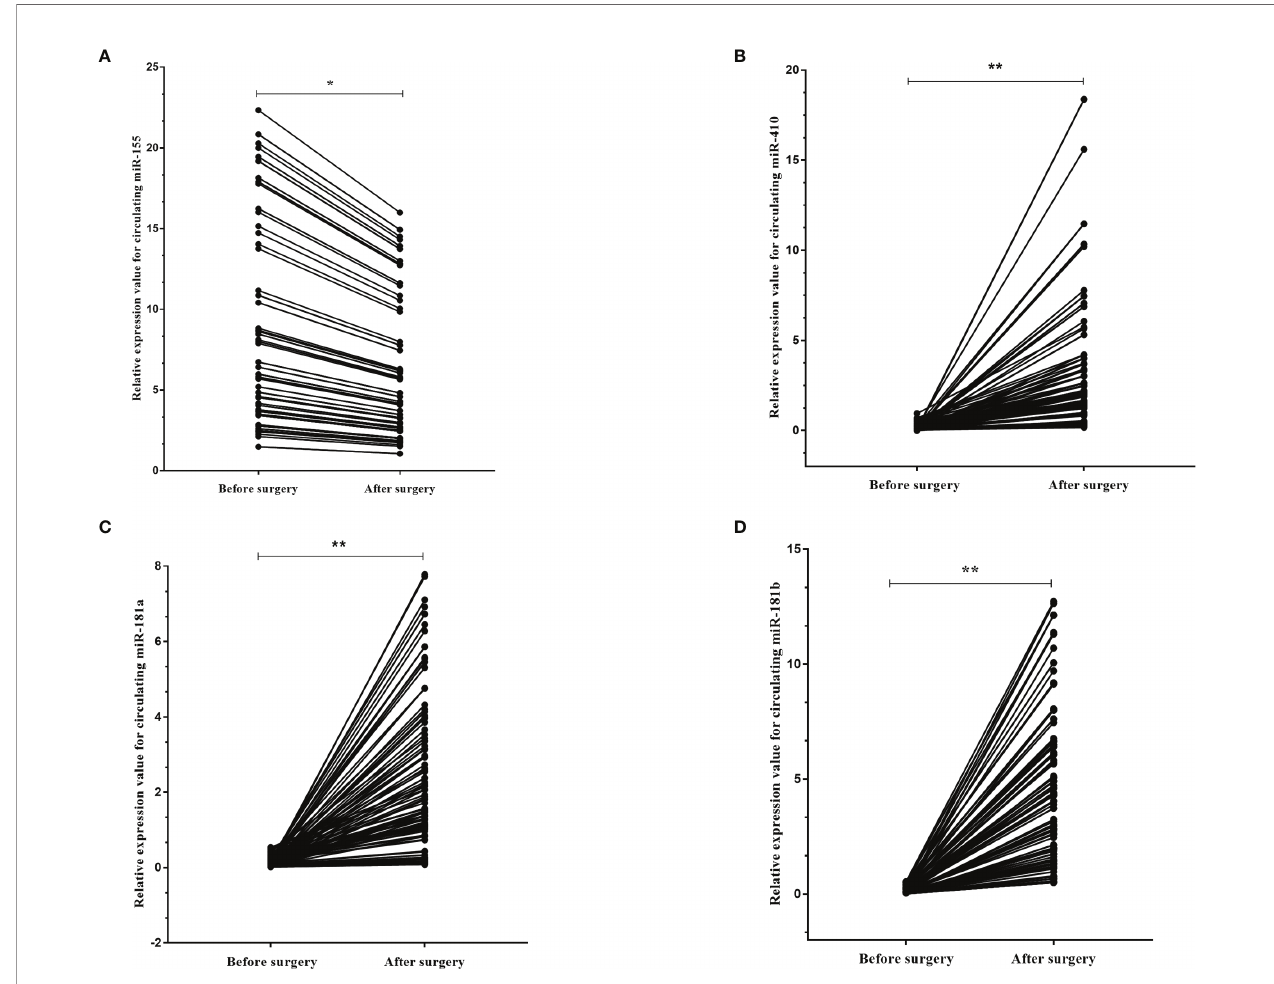
FIGURE 6 | The dynamic change of circulating miR-181a/b, miR-410 and miR-155 in plasma samples of high-grade glioma patients before and after surgery. The expression levels of the 4 circulating miRNAs in the patients before and after surgery (A – D) . Each point represents the mean of the triplicate samples. A probability of p < 0.05 (*) or p < 0.001 (**) was considered statistically signi fi